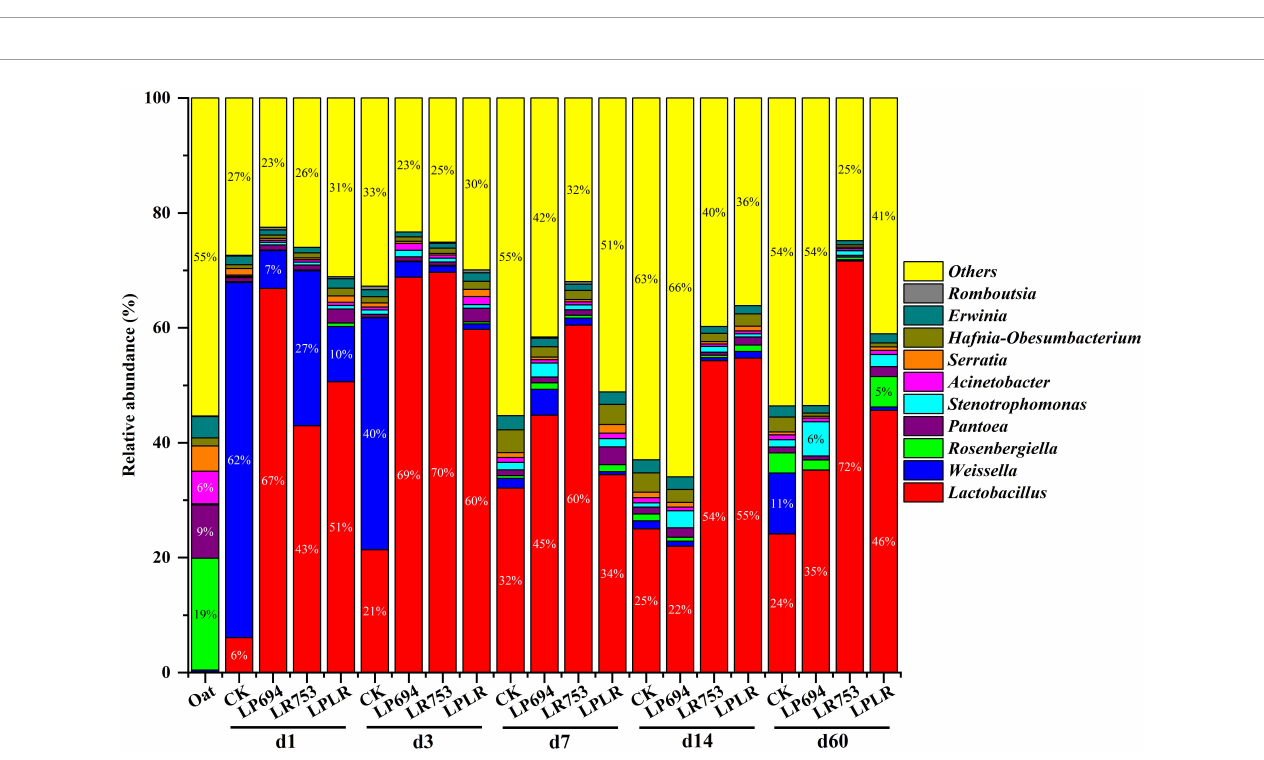
FIGURE1 Relative abundance of bacteria at phylum level for oat silages at different days of fermentation with and without lactic acid bacterial inoculation. CK, sterilized water; LP694, Lactobacillus plantarum 694; LR753, Lactobacillus rhamnosus 753; LPLR, 50% LP694 + 50% LR753; d, ensiling days; OAT.F, fresh oat.